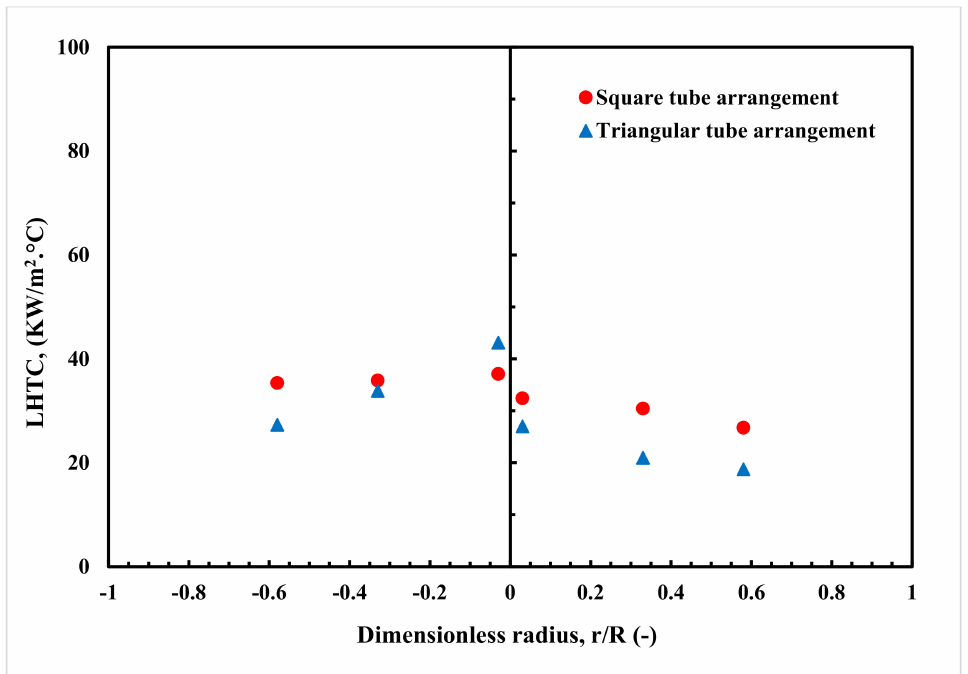
Figure 8. LHTC profiles measured at the axial level of 65 cm and an operating gas velocity of 0.15 m/s.